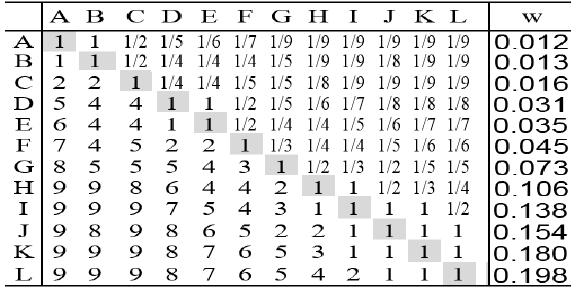
Table 1. AHP matrix (A: temperature, B: aspect, C: distance to road, D: rain, E: population density, F: slope, G: DEM, H: distance to lake, I: Distance to river, J: distance to landslide,